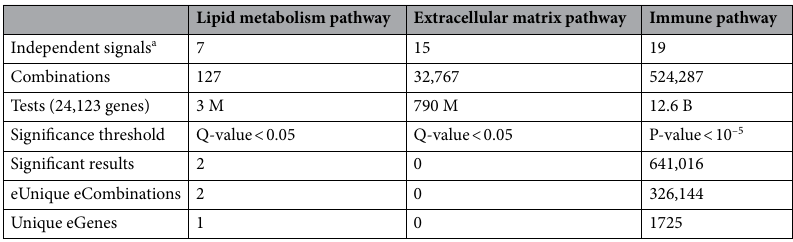
Table 1. Statistical overview of variant interactions investigated. a Independent signals = independent AMD- associated genetic variants as defined by Fritsche et al.